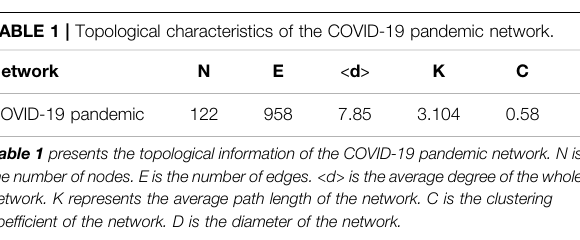
TABLE 1 | Topological characteristics of the COVID-19 pandemic network. Network